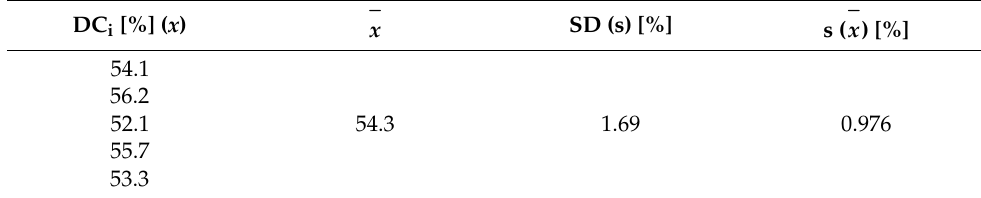
Table 2. Exemplary statistical analysis based some results.